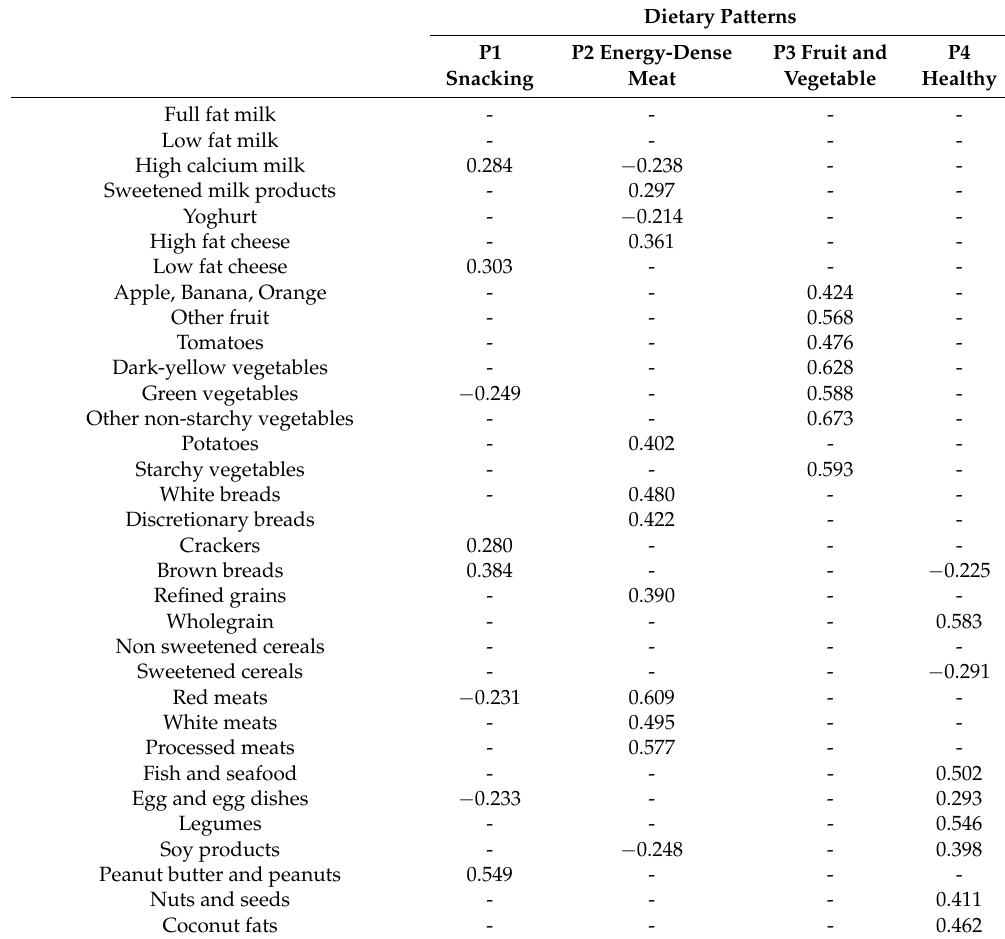
Table 2. Factor loading matrix for the four dietary patterns identified in NZE women ( n = 231), aged 16–45